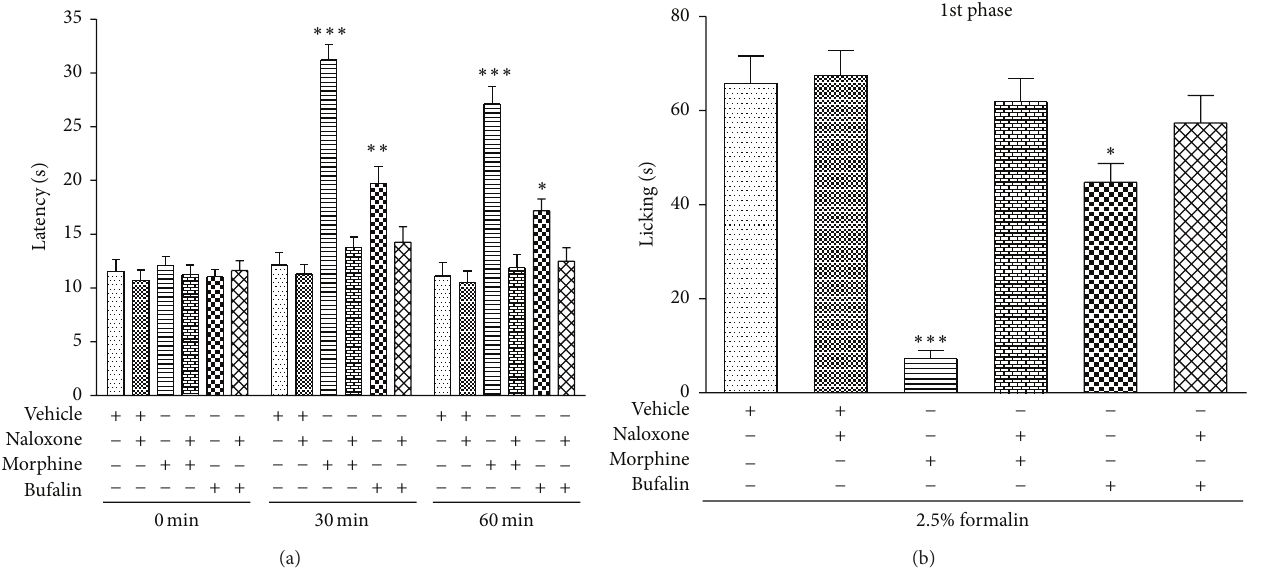
Figure 5: Pretreatment effect on mice with naloxone (2mg/kg, i.p.) in the antinociception induced by bufalin (0.6mg/kg, i.p.) in the hot-plate test (a) and the first phase of formalin test (b). Data are expressed as the mean ± S.E.M. ( 𝑛 = 8 ), ∗ P < 0.05, ∗∗ P < 0.01, and ∗∗∗ P < 0.001, compared with the vehicle group.